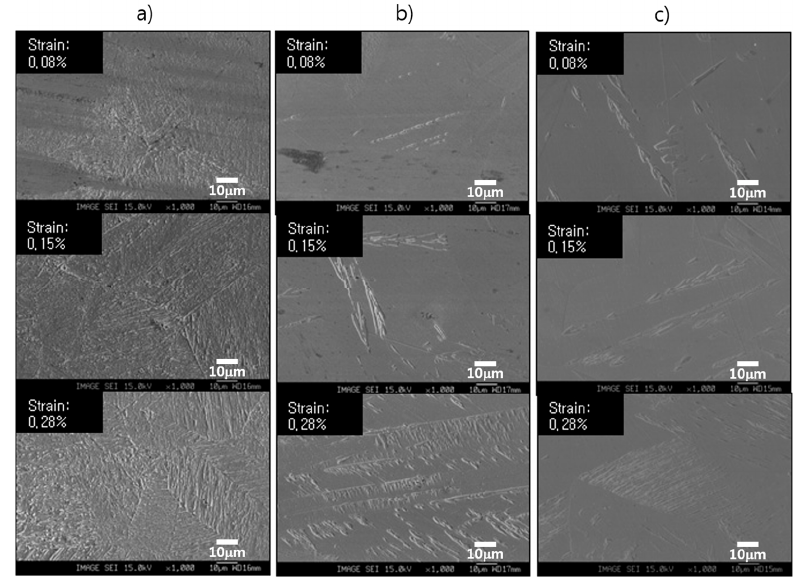
Figure 5. Scanning electron microscopy (SEM) iamges showing α ’-martensite formation in specimen A ( a ), B ( b ), and C ( c